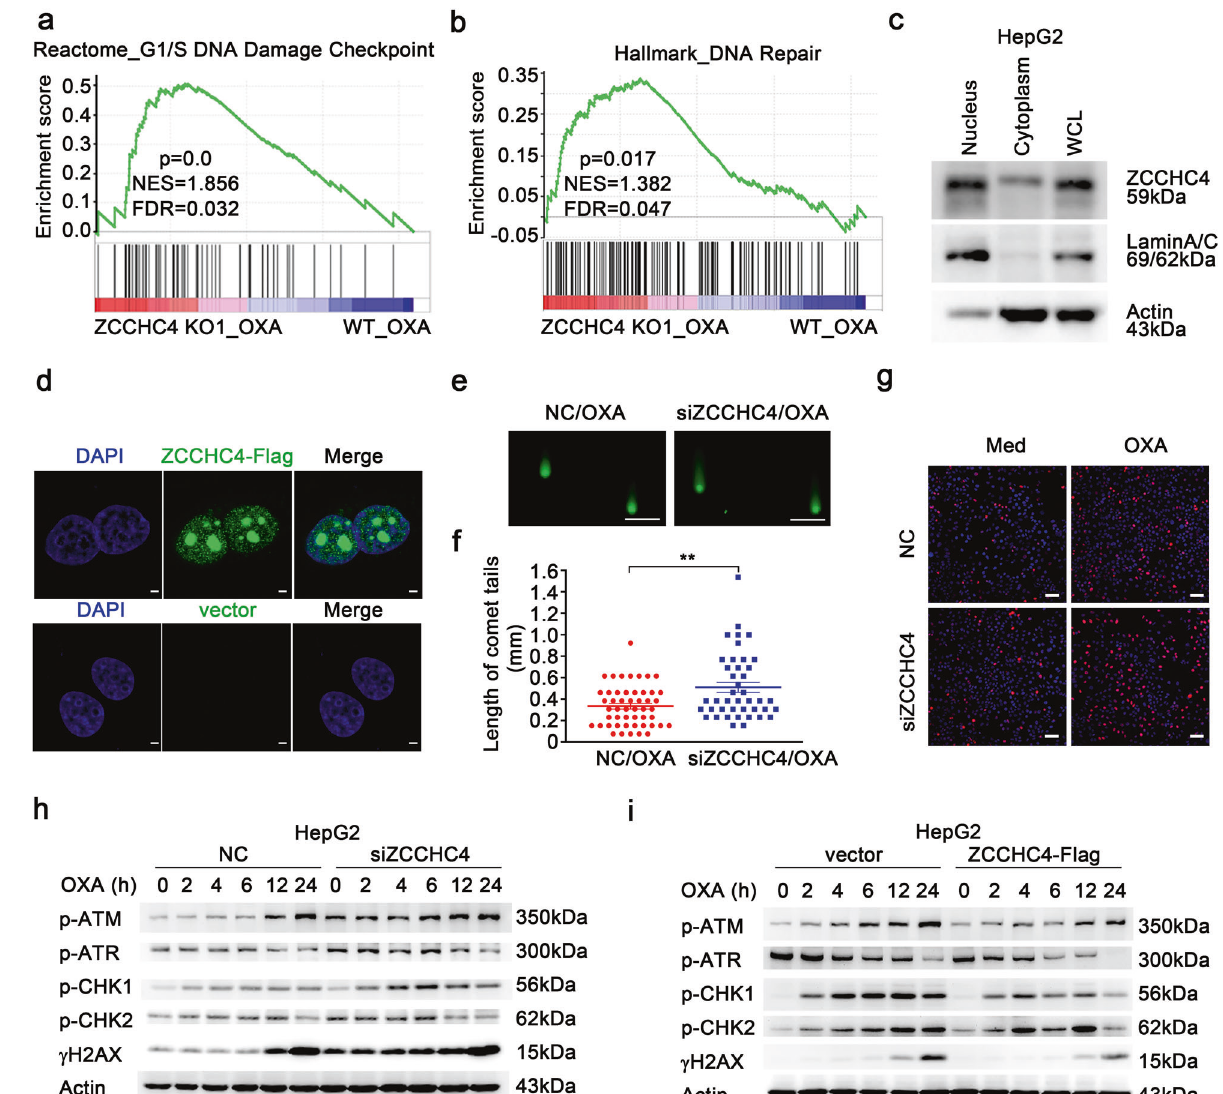
Fig. 4 ZCCHC4 restrains oxaliplatin-induced DNA damage. a , b GSEA analysis of ZCCHC4 KO1 cells and WT cells with OXA (62.5 µM) treatment for 12 h. Reactome ( a ) and hallmark database ( b ) were referred. c Representative immunoblot analysis of ZCCHC4 expression in the nucleus and cytoplasm of HepG2 cells. d Representative immuno fl uorescence images (scale bar = 2.5 µm) for ZCCHC4 expression (green) in ZCCHC4- Flag or empty vector-transfected HepG2 cells. ZCCHC4-Flag, Flag-tagged ZCCHC4-expressing vector. e , f Comet assay for NC- or ZCCHC4 - silenced HepG2 cells with OXA (62.5 µM) stimulation for 12 h. Representative images (scale bar = 1 mm) ( e ) and lengths of comet tails ( n = 50 and n = 42 for NC and siZCCHC4 group, respectively) ( f ) were shown. ** P < 0.01 as determined by unpaired Student ’ s t test ( f ). NC non-speci fi c siRNA control. g Representative immuno fl uorescence images (scale bar = 75 µm) showing γ H2AX expression in NC- or ZCCHC4 - silenced HepG2 cells with OXA (62.5 µM) stimulation for 6 h. h , i Immunoblot analysis of phosphorylated ATM, ATR, CHK1, CHK2, H2AX levels in HepG2 cells with or without ZCCHC4 silence ( h ) or overexpression ( i ) followed by OXA (62.5 µM) stimulation for indicated hours. One representative experiment of three is